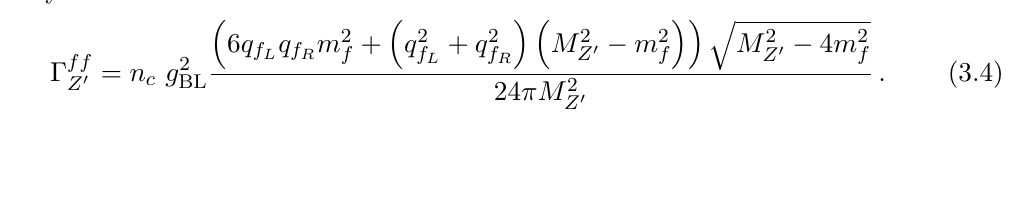
f (cid:22) f via the Z 0 boson and (cid:31) (cid:22) (cid:31) ! < m 2 . Since the process (cid:31) (cid:22) (cid:31) (cid:31) Z 0